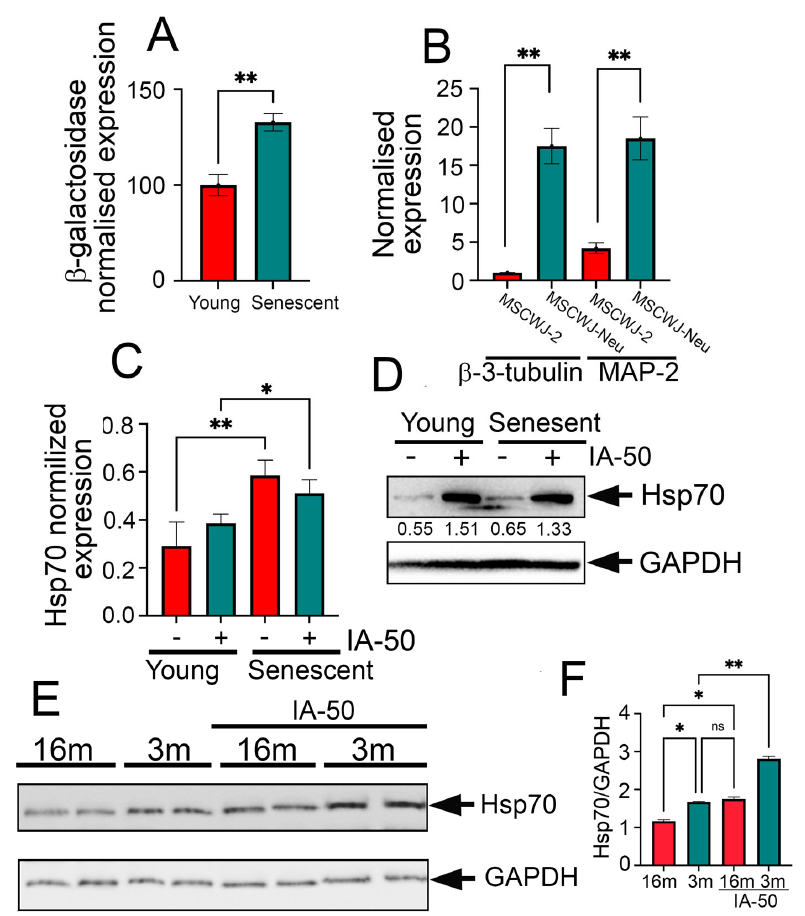
Figure 3. IA ‐ 50 induces transcription of heat shock genes and causes the accumulation of heat shock proteins in senescent neurons and in the hippocampi of aged mice. ( A ) Data on differentiation of MSCWJ ‐ 2 cells into MSCWJ ‐ Neu with a neuronal phenotype. Real ‐ time PCR data are presented. Bars show the relative amount of RNA transcripts with MAP ‐ 2 or b ‐ 3 ‐ tubulin in MSCWJ ‐ 2 or MSCWJ ‐ Neu cells. Data from three independent experiments are presented, * p < 0.05; ** p < 0.001. ( B ) b ‐ galactosidase level in MSCWJ ‐ Neu cells induced into a neuronal phenotype from MSCWJ ‐ 2 cells at “5th and 15th passage” (qPCR data). ( C ) An analysis of the Hsp70 expression in young and senescent MSCWJ ‐ NEU cells after incubation with 1 μ M IA ‐ 50 for 6 h. The results of RT ‐ PCR. * p < 0.05; ** p < 0.001 ( D ) Western blotting of young and senescent MSCWJ ‐ NEU cells incubated with 1 μ M IA ‐ 50 for 24 h with anti ‐ Hsp70 antibody. GAPDH was used as a loading control. ( E ) Western blot of the hippocampi of 3 ‐ or 16 ‐ month ‐ old mice treated with IA ‐ 50 (10 μ g/kg) 24 h after intraper ‐ itoneal injection. GAPDH was used as a loading control. The hippocampi of 2 mice were used for each point. ( F ) Band intensity was measured using StudioLite software (Li Cor, France). * p < 0.05; ** p < 0.001. Then, we used Western blotting to measure the Hsp70 concentration in young and aged MSCWJ ‐ Neu cells and found that IA ‐ 50 was able to cause Hsp70 accumulation in both types of cells (Figure 3D). To estimate the Hsp70 ‐ inducing effect in brain tissue, we injected IA ‐ 50 (10 μ g/kg) in 3 ‐ and 16 ‐ month ‐ old mice, and 72 h later, the animals were sacrificed, the hippocampi were isolated and subjected to Western blotting. As revealed by Western blotting, IA ‐ 50 was able to cause Hsp70 accumulation in the hippocampi of both young and aged mice, suggesting that the substance is able to increase Hsp70 in vitro and in vivo to a similar extent in older and younger animals (Figure 3E).